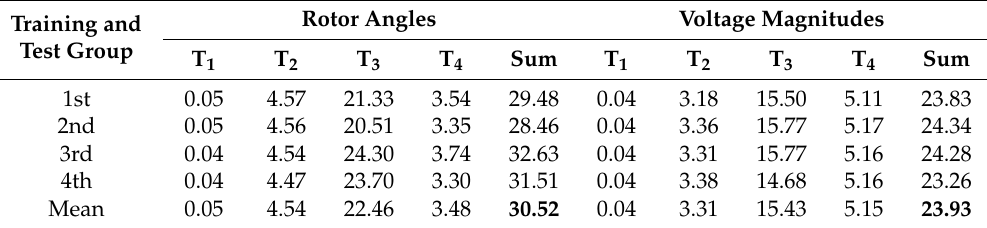
Table 4. Processing time for the GTCFS set.